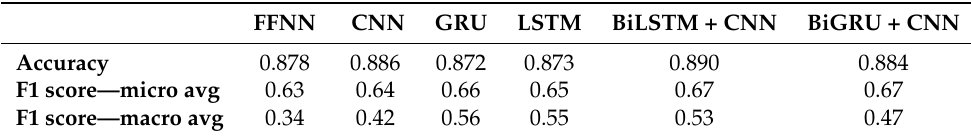
Table 4. Initial evaluation of the